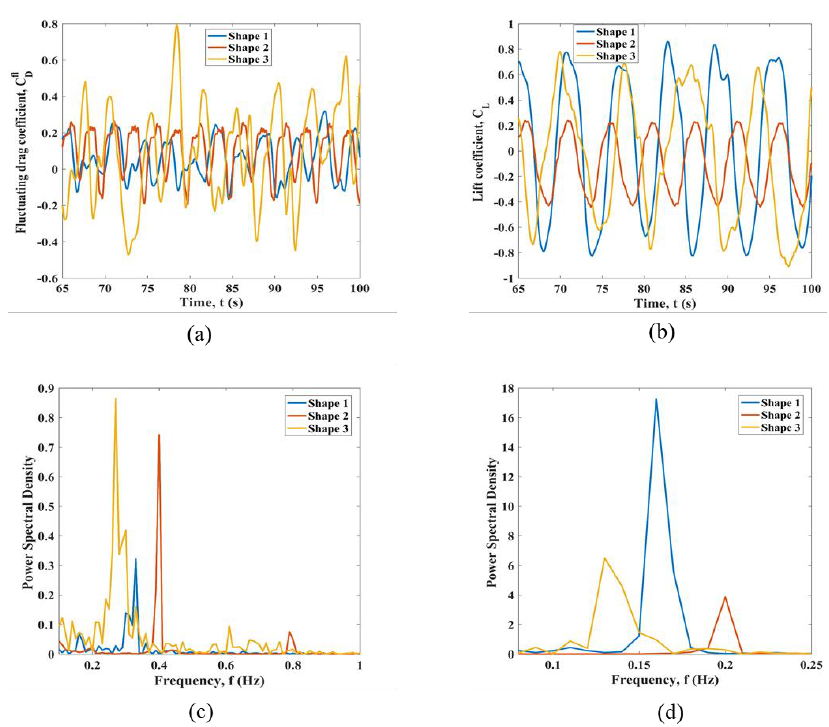
Figure A13. Fluid force coefficients for cylinder 4 immersed in uniform flow: ( a ) time history of the fluctuating drag coefficient; ( b ) time history of the lift coefficient; ( c ) the fluctuating drag coefficient FFT; ( d ) the lift coefficient FFT.